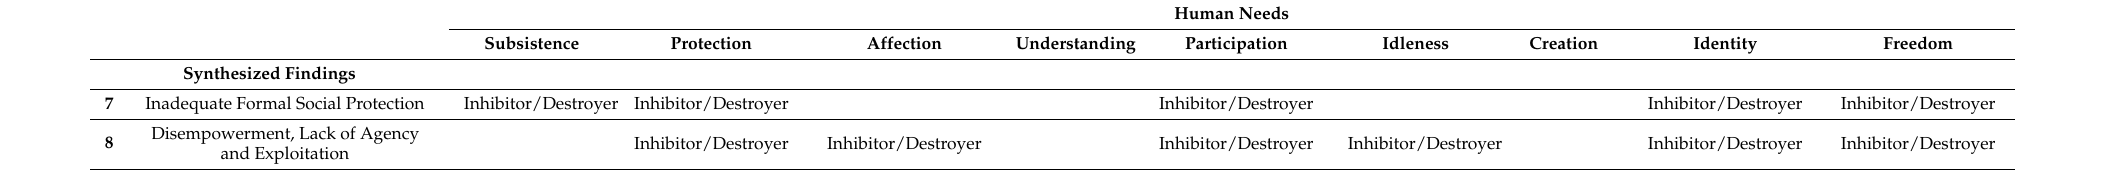
Table 4. Inhibitors/Destroyers of Human Needs for Asylum Seekers and